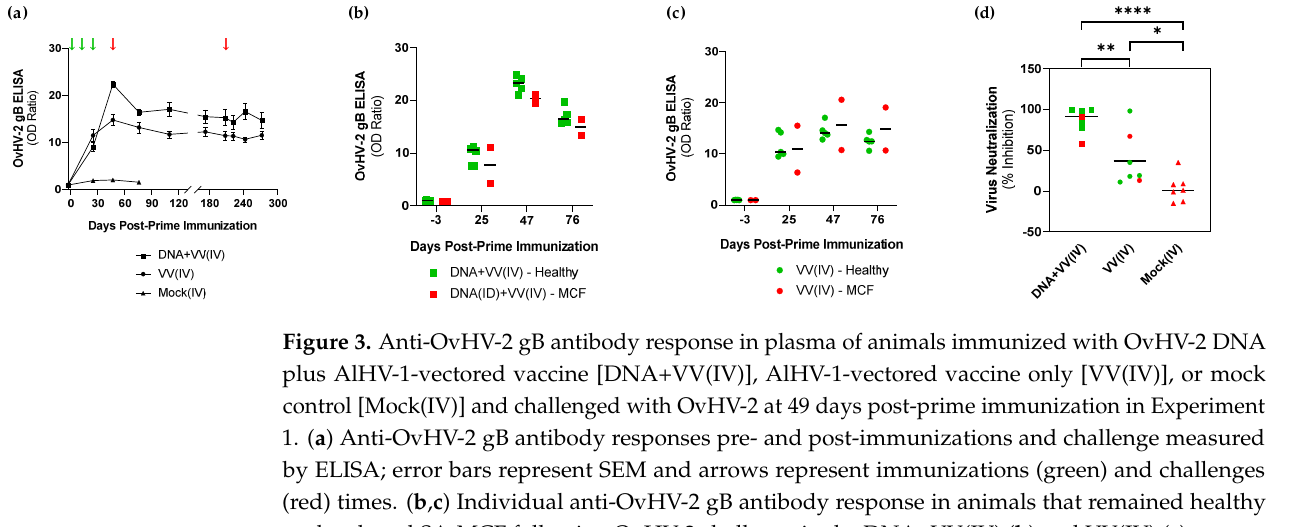
DNA+VV(IV) immunized group was higher than in the VV(IV) group ( p = 0.0022), no dif- ference was observed between immunized animals that developed MCF or remained healthy after challenge in any group (Figure 3d).